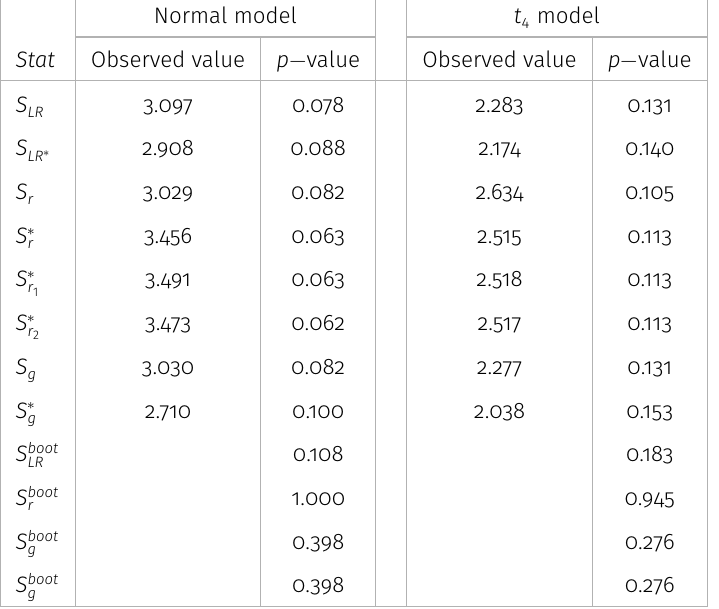
Table III. Test statistics and p − values for testing H